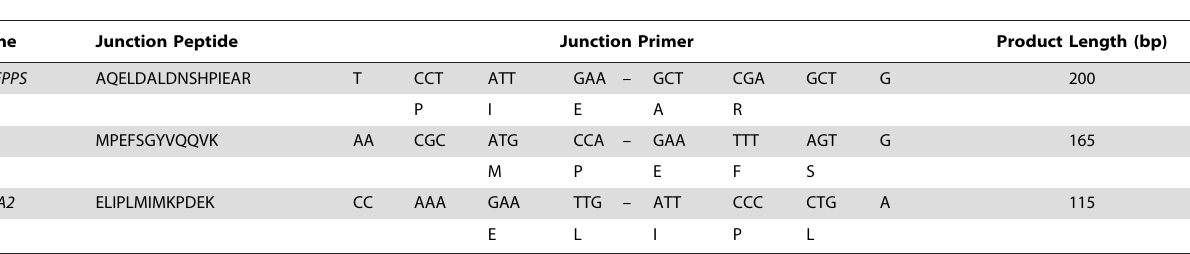
Table 2. Design of exon-junction-spanning PCR primers.